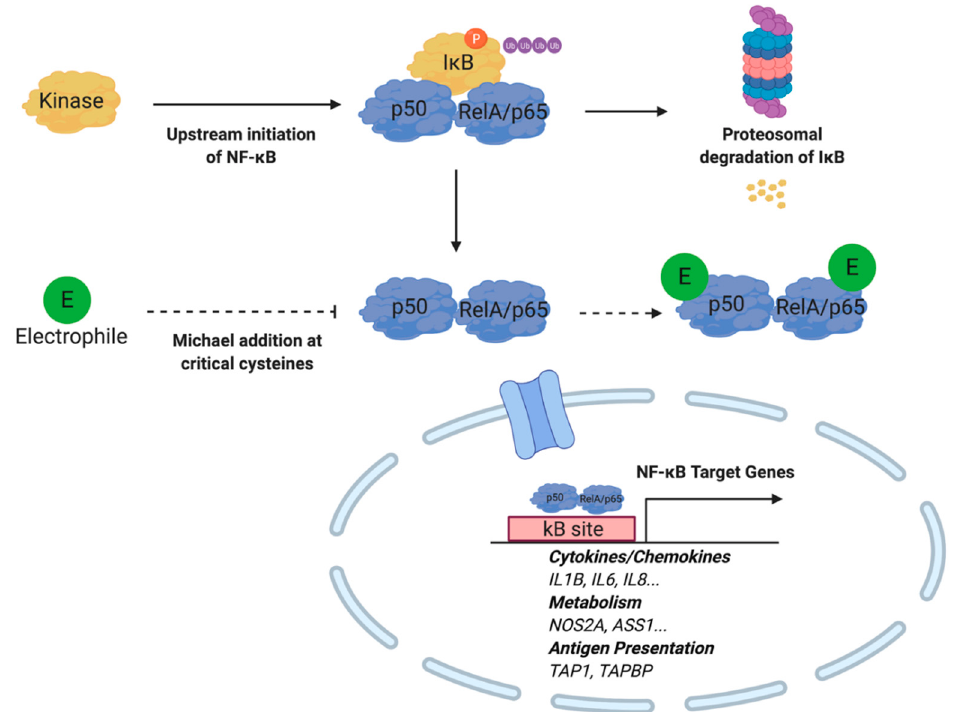
Figure 5. Electrophiles inhibit NF- κ B activity by binding to the p50 and RelA / p65 protein subunits. Michael addition at cysteine moieties prevent nuclear translocation required for target gene expression. Under inflammatory conditions, kinase activity induced by upstream NF- κ B signaling results in phosphorylation, ubiquitinylation, and proteasomal degradation of I κ B. Subsequently, NF- κ B translocates to the nucleus to initiate target gene expression.